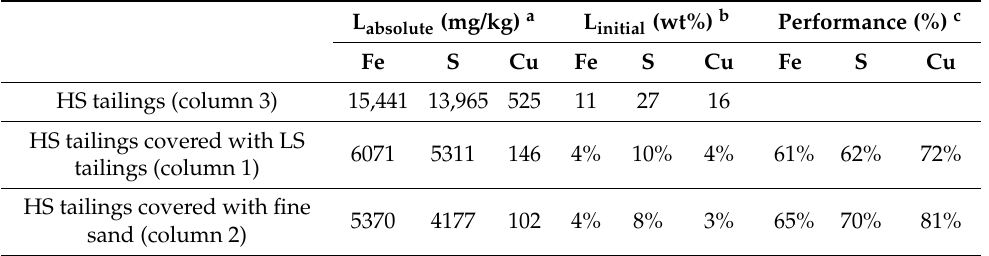
Table 4. Calculated masses of Fe, S, and Cu leached from the columns during the whole experiment, and comparison with initial concentrations in HS